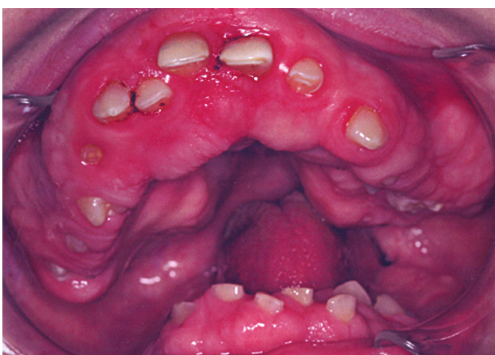
Figure 5: Recurrence of gingival hyperplasia at 16 years of age (permanent